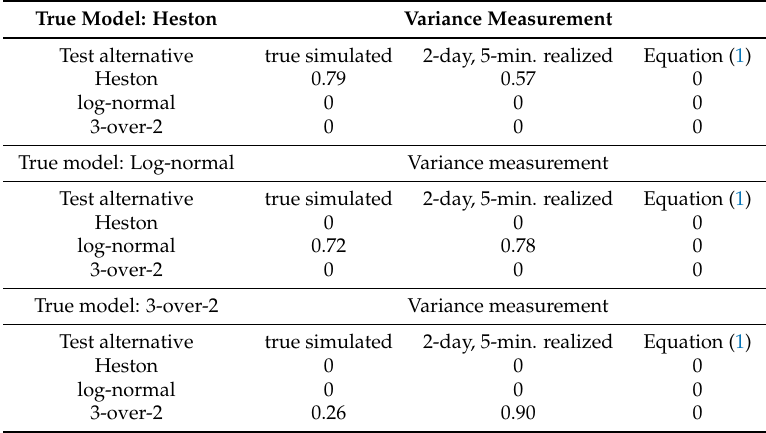
Table 2. Discriminatory power of Kolmogorov-Smirnov tests on uniform residuals for different methods of variance measurement: p -values from the chi-square test under the hypothesis indicated in the test alternative